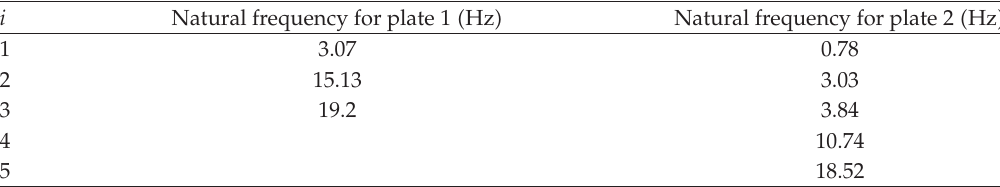
Table 2: Natural frequencies of plates 1 and